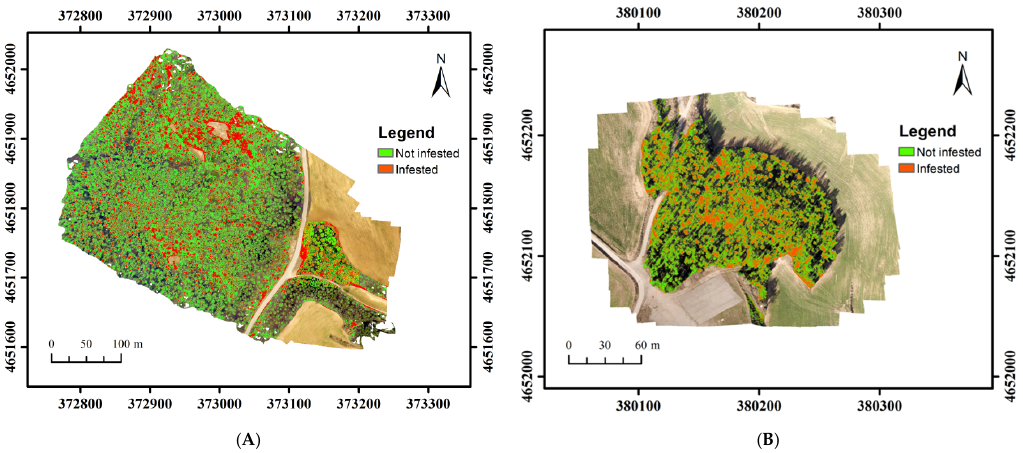
( b ) Figure 5. ( a ) Linear regression model between defoliation measured in the field and through UAS images in Torregassa forest site; ( b ) Defoliation using a 1 ‐ m buffer around the tree top and using manual crown delineation. n = 81. Red = completely defoliated; grey = infested; green = non ‐ infested.